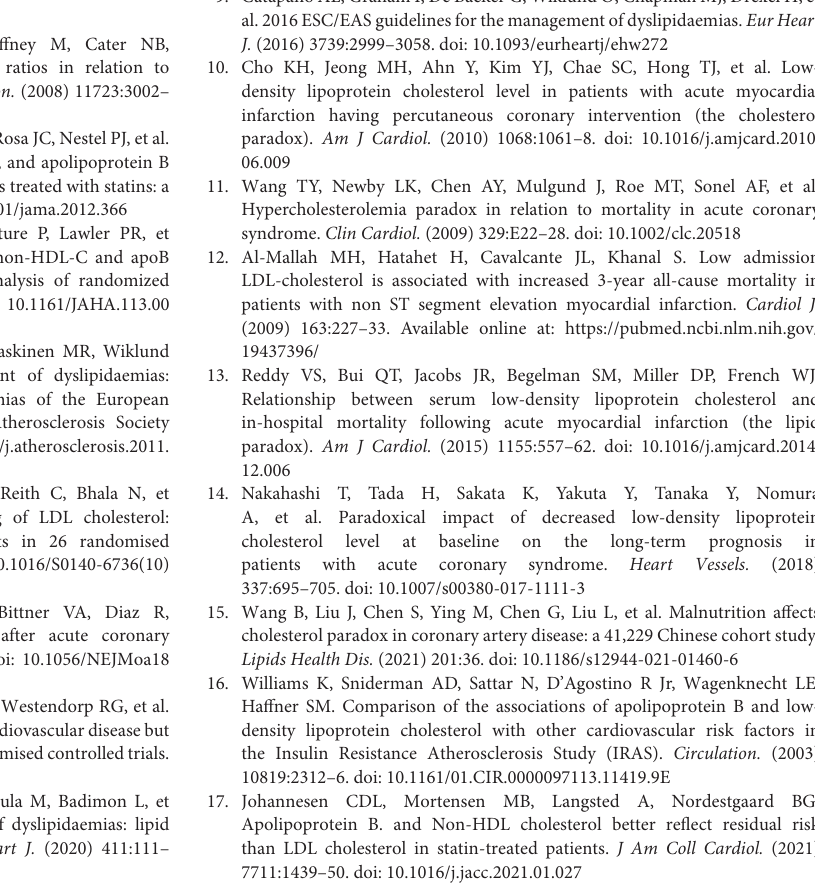
Supplementary Figure 1 | Unadjusted and adjusted HRs and 95% CIs for the primary end point (long-term all-cause mortality) of ApoB < 65 mg/dL group vs. ApoB ≥ 65 mg/dL group in CAD patients. Model 1: Unadjusted model. Model 2: Adjusted for age ≥ 75 years, sex, PCI and comorbidities including AMI, CHF, hypertension, diabetes mellitus, CKD, anemia, atrial fibrillation, COPD, stroke and the use of stain. Model 3: Adjusted for malnutrition. Model 4: Adjusted for all covariates: age ≥ 75 years, sex, PCI and comorbidities including AMI, CHF, hypertension, diabetes mellitus, CKD, anemia, atrial fibrillation, COPD, stroke, malnutrition and the use of stain. Supplementary Figure 2 | Restricted spline curve of the Baseline ApoB hazard ratio for mortality (long-term all-cause mortality) in CAD patients. (A) : Model 1, Unadjusted model. (B) : Model 2, Adjusted for age ≥ 75 years, sex, PCI and comorbidities including AMI, CHF, hypertension, diabetes mellitus, CKD, anemia, atrial fibrillation, COPD, stroke and the use of stain. (C) : Model 3, Adjusted for malnutrition. (D) : Model 4, Adjusted for all covariates: age ≥ 75 years, sex, PCI and comorbidities including AMI, CHF, hypertension, diabetes mellitus, CKD, anemia, atrial fibrillation, COPD, stroke, malnutrition and the use of